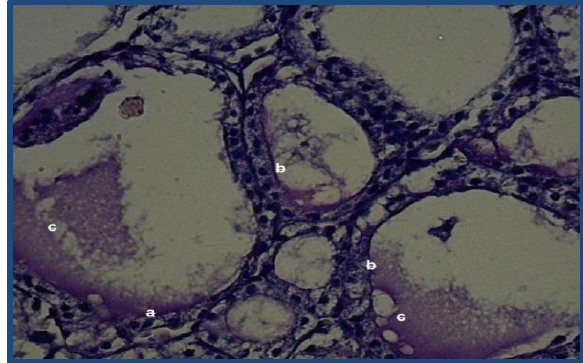
Figure, 6: Thyroid gland showed: a- Active follicles b- highly active follicles c- Follicular lumen contain vacuolated colloid d- Considerable variation in the follicular (PAS stain, 40X).